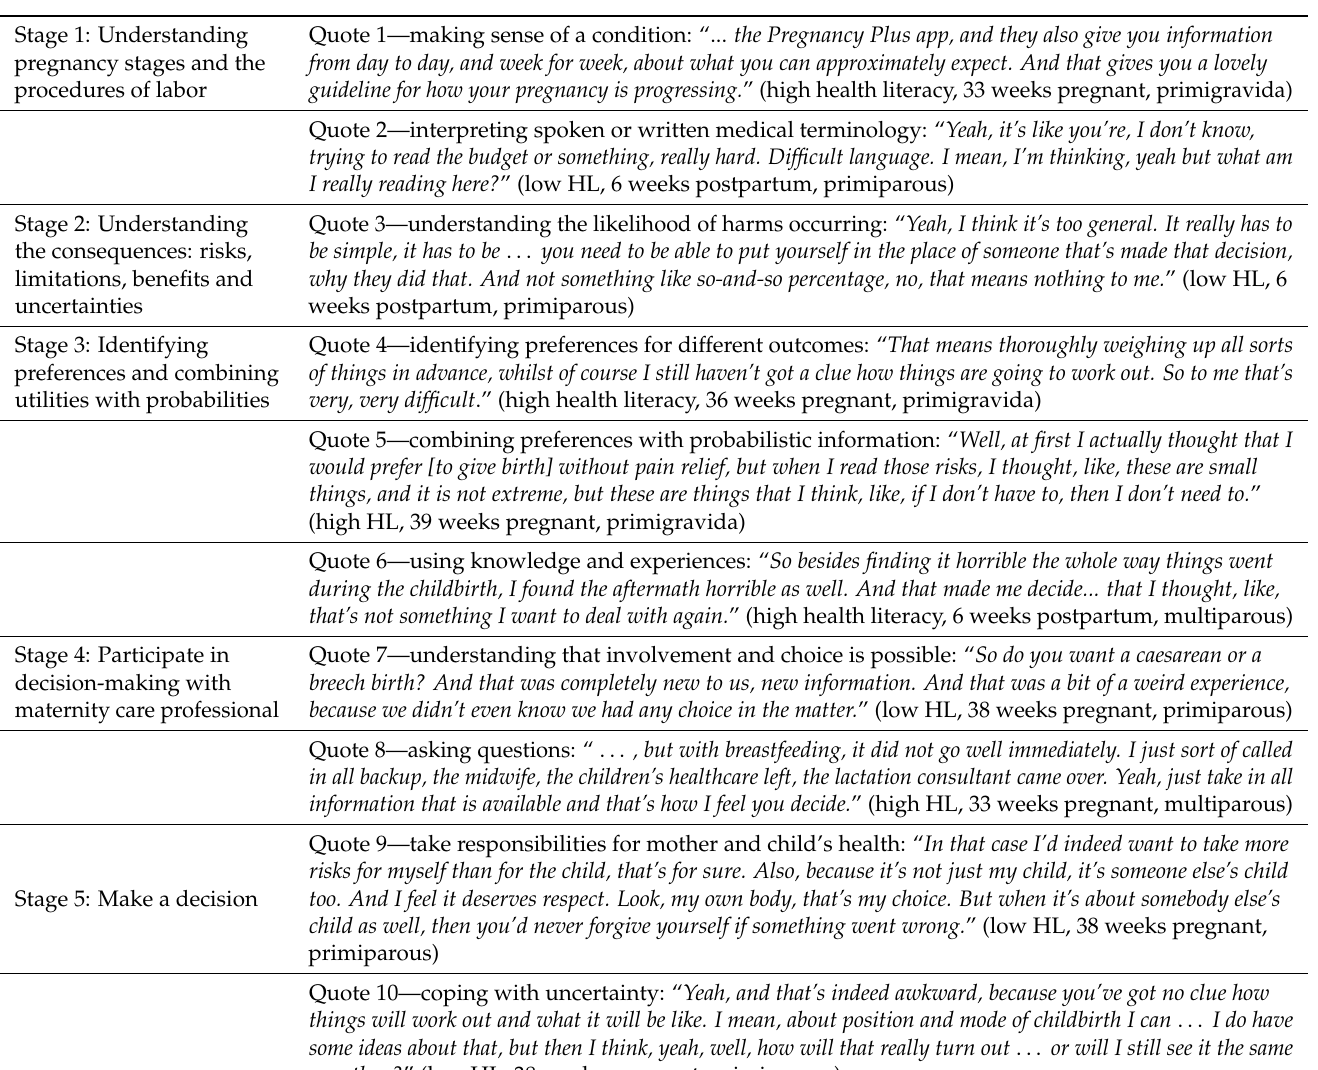
Table 3. Example quotes—decision-making stages and